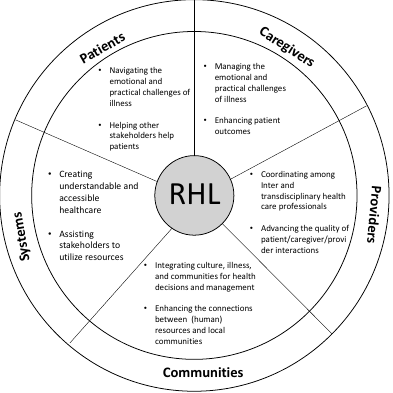
Figure 1. Relational Health Literacy Conceptual Model.